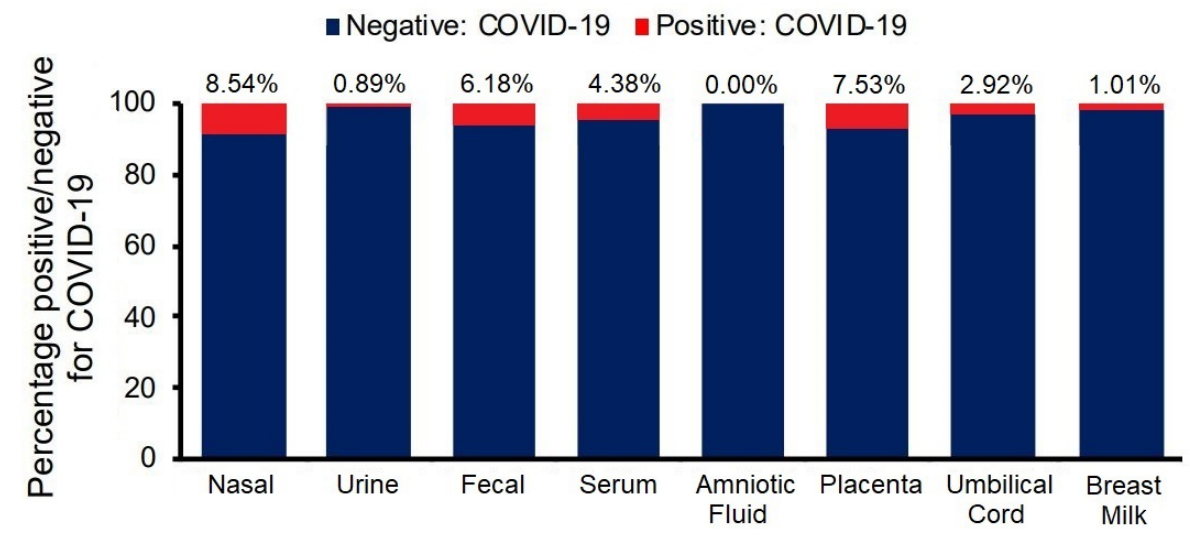
Figure 2. Maternal PCR test results.